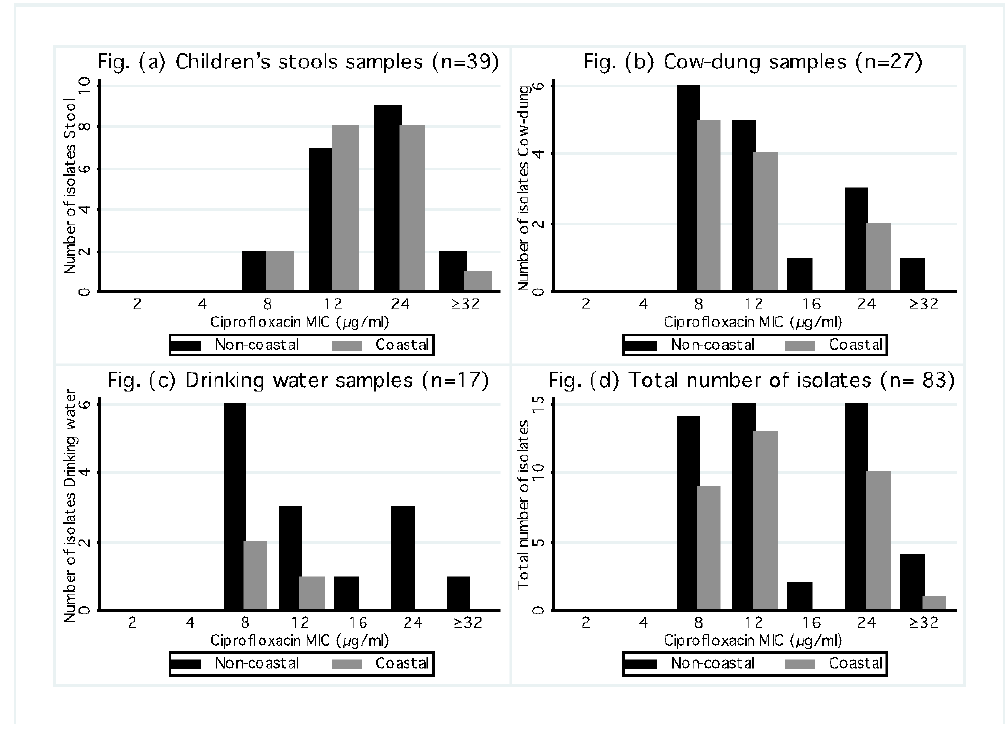
Figure 1. Ciprofloxacin MIC (Minimum inhibitory concentration) values among ciprofloxacin-resistant E. coli isolates from ( a ) Children’s stools samples ( n = 39); ( b ) Cow-dung samples ( n = 27); ( c ) Drinking water samples ( n = 17); and ( d ) Total number of isolates ( n =